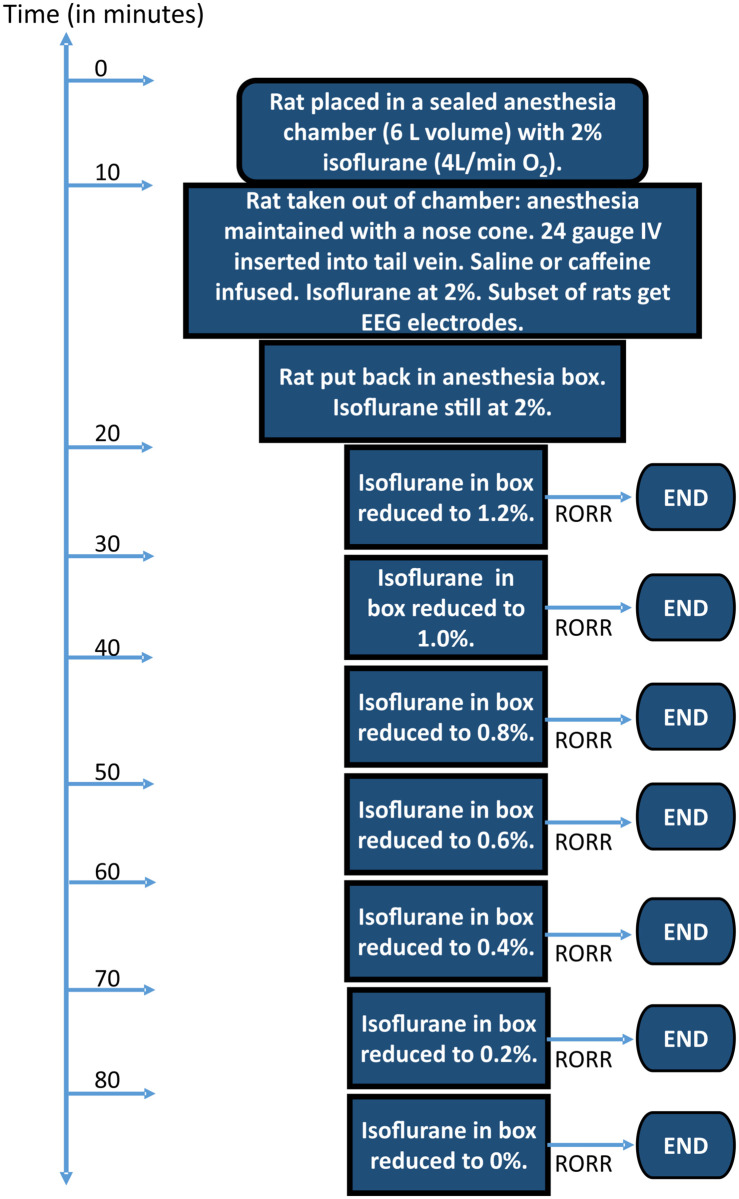
Schematic of experimental design.Note that the time bar is not to scale.